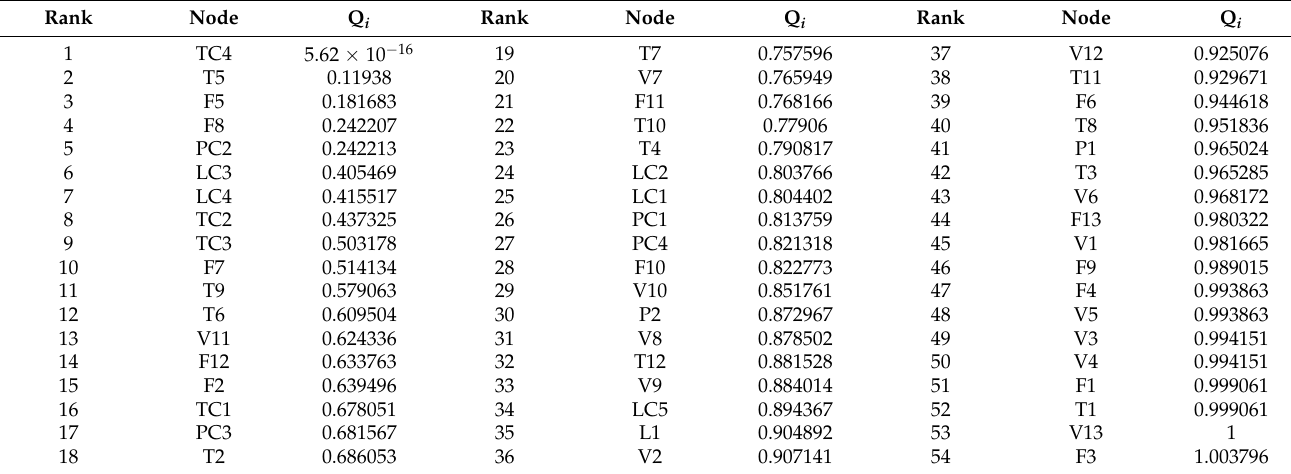
Table 3. The ranking result of all